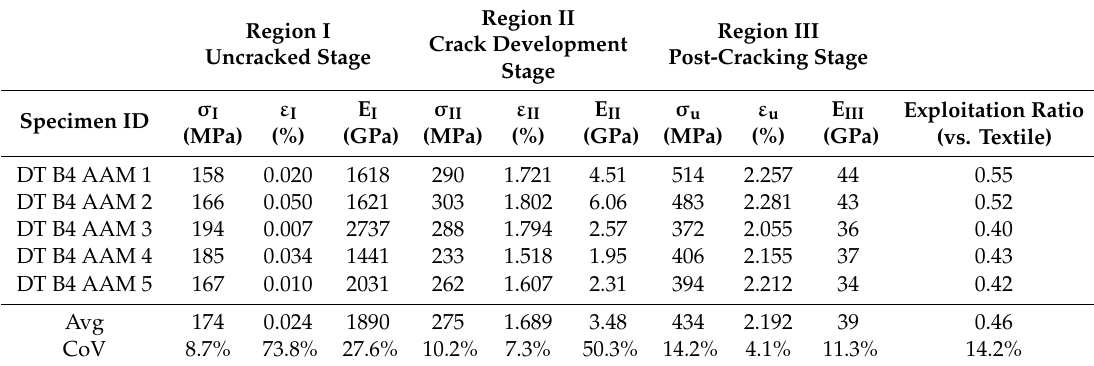
Table 4. Results of tensile tests on composite specimens: the main values related to the